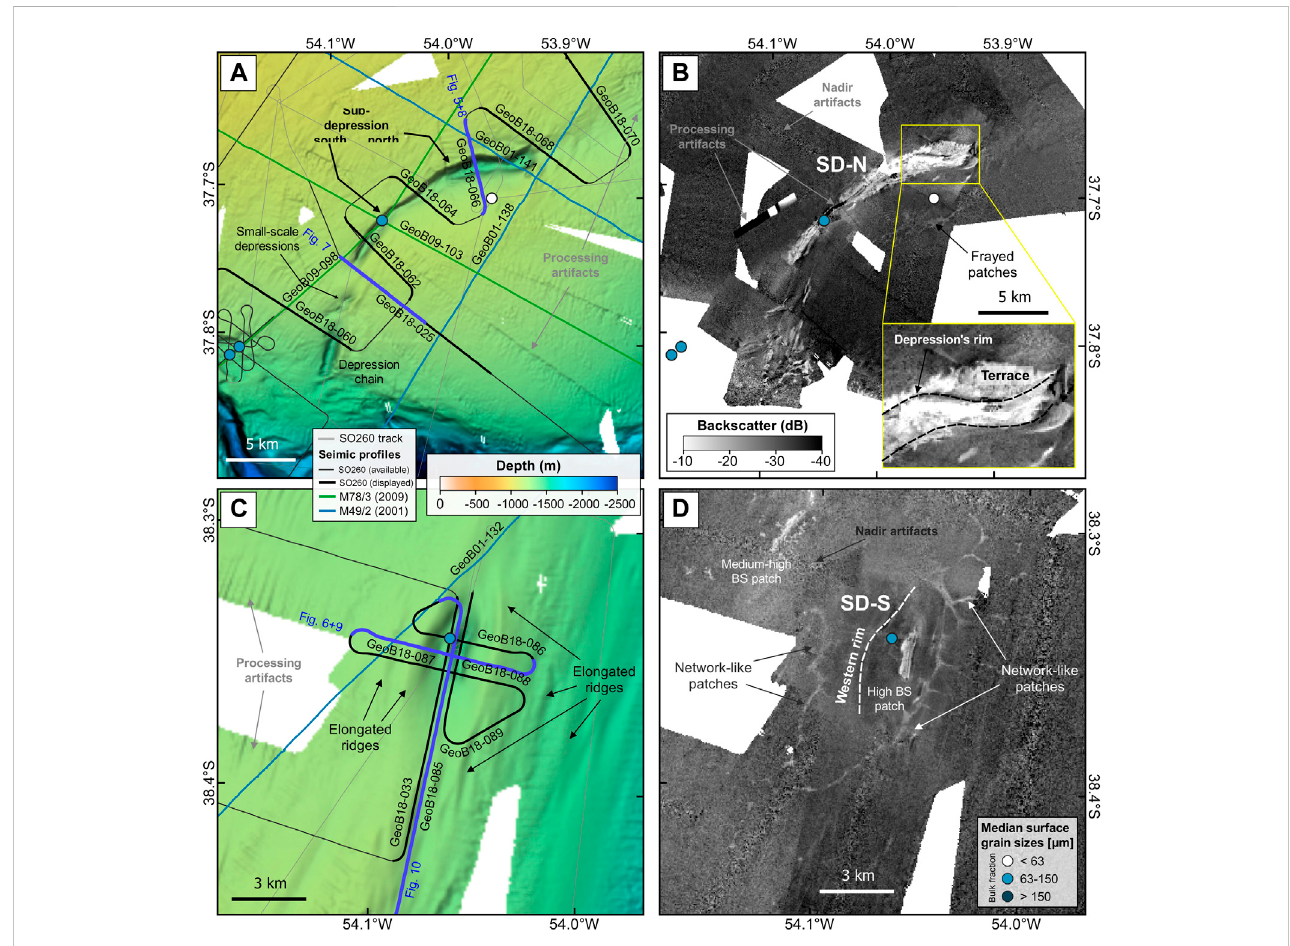
FIGURE 4 Available datasets. (A) Close-up bathymetryaround SD-N with seismo-acoustic pro fi les from cruises M78/3 (2009) and SO260 (2018). Different colored lines show interpreted seismic pro fi les, cruise track of SO260 (thin grey), and seismic sections (thick blue) displayed in Figures 7, 8. (B) Backscatter mosaic around SD-N showing high backscatter intensities (white) for the area of SD-N, whereas the surrounding sea fl oor is mainly characterized by low intensities (dark grey). Yellow box marks the extent of the small inset map displaying backscatter anomalies outside the northern sub-depression of SD-N. (C) Close-up bathymetry around SD-S with acoustic pro fi les from M49/2 (2001) and SO260 (2018). Same color-coded lines as for (A) . (D) Backscatter mosaic around SD-Sshowingahighbackscatter intensity patchattheeastwards fl ank.The western rim(dashedwhite line)isbarely visible, whereas theeasternrimis characterized by fuzzy network-like patches of elevated intensities. Colored circles indicate the grain sizes of sediment surface samples (Wilckens et al., 2021a; Wilckens et al.,